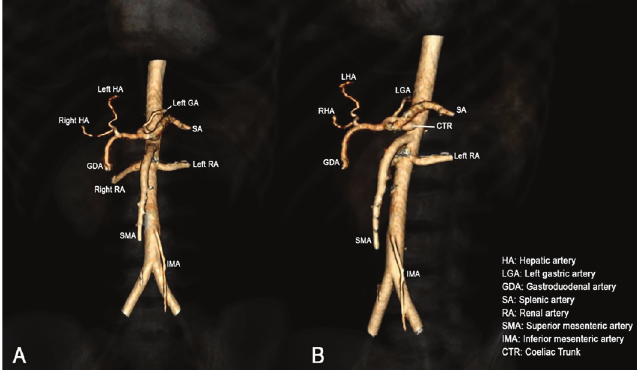
Figure 1 - Three-dimensional reformat CTA images (A,B) show a normal arterial anatomy (HA: Hepatic artery, LGA: Left gastric artery, GDA: Gastroduodenal artery, SA: Splenic artery, RA: Renal artery, SMA: superior mesenteric artery, IMA: inferior mesenteric artery, CTR: Coeliac